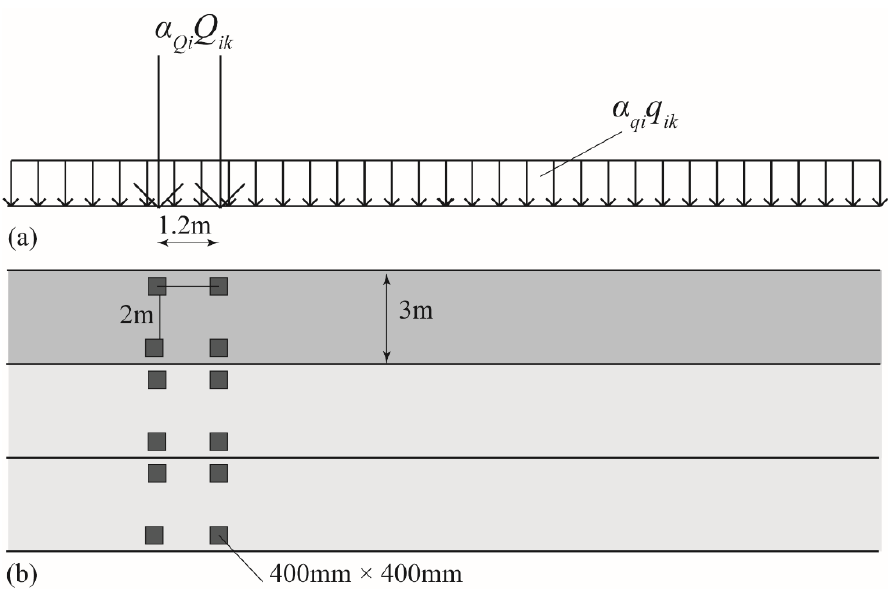
Figure 2. Live load model 1 from NEN-EN 1991-2:2003 [1]: ( a ) elevation; ( b ) top view. Edited from Reference [12], and reprinted with permission.